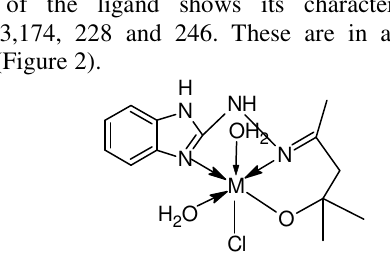
Figure 2 . Structure of the metal complexes, where M=Mn(II), Ni(II) and